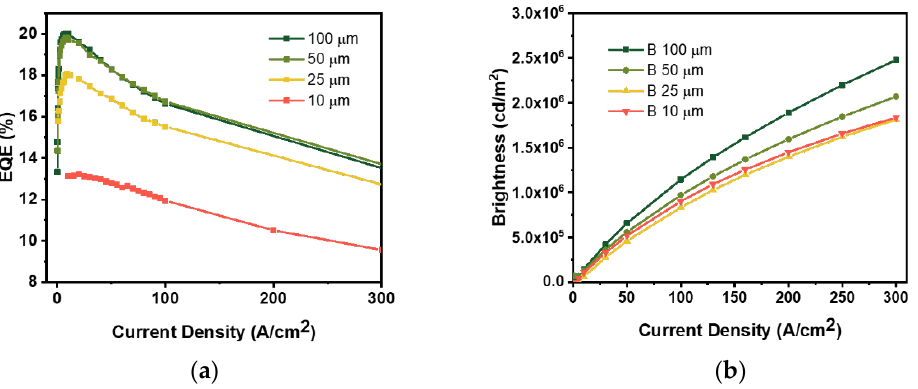
Figure 3. ( a ) EQE as a function of current density for different sizes of blue micro-LEDs; ( b ) brightness as a function of current density for different sizes of blue micro-LEDs.